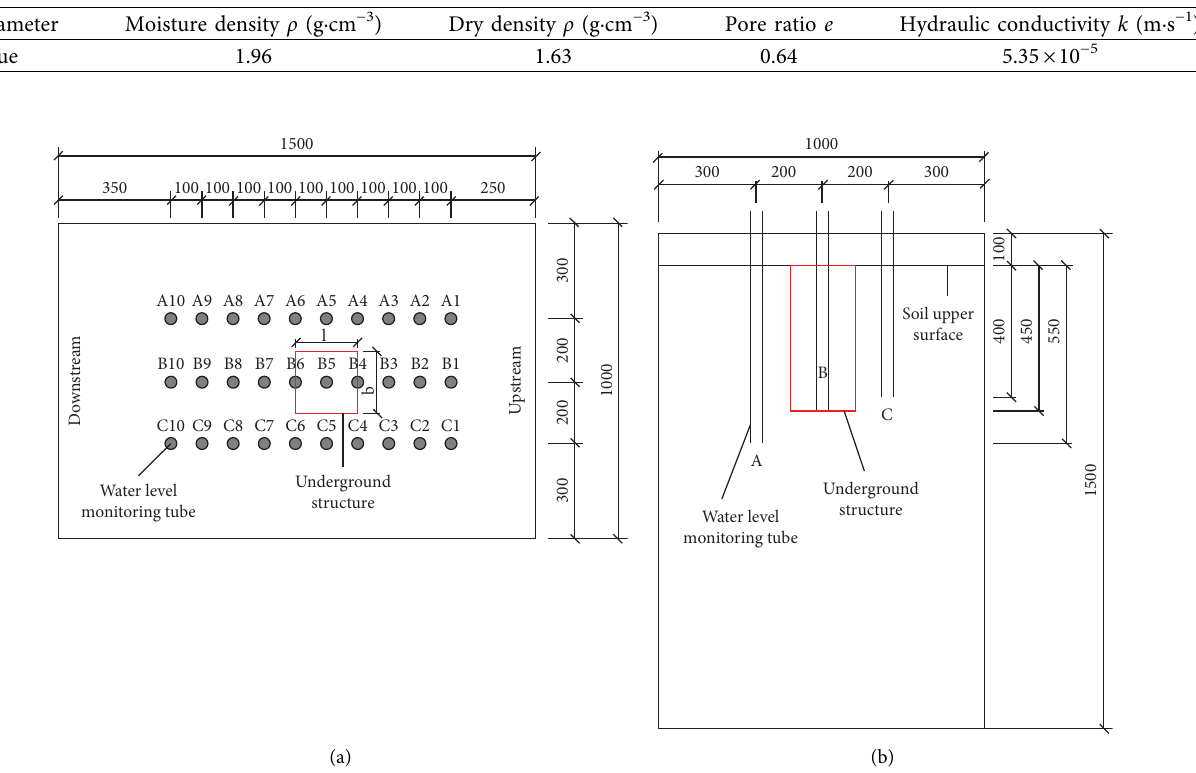
Figure 1: Schematic view of the laboratory test system (unit: Table 1: Parameters of the sand in laboratory test.